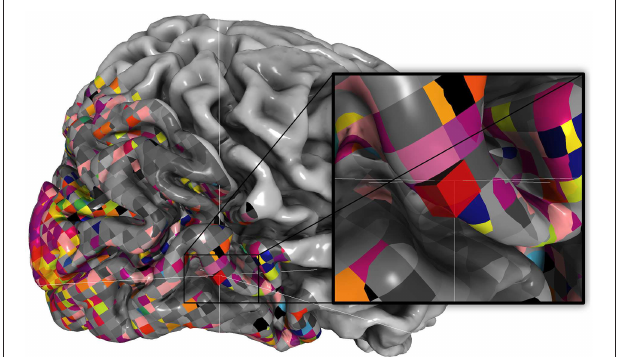
FIGURE 3 | Retinotopic data for example subject. Pixel-based mapping in pycortex renders voxels true-to-form. Here, a retinotopic map as in Hansen et al. (2007) is plotted using webgl . Note that the slanted slice prescription and the isotropic voxel size is easily visible due to pixel-based mapping and nearest-neighbor sampling. The inset shows how a single voxel intersects the surface.